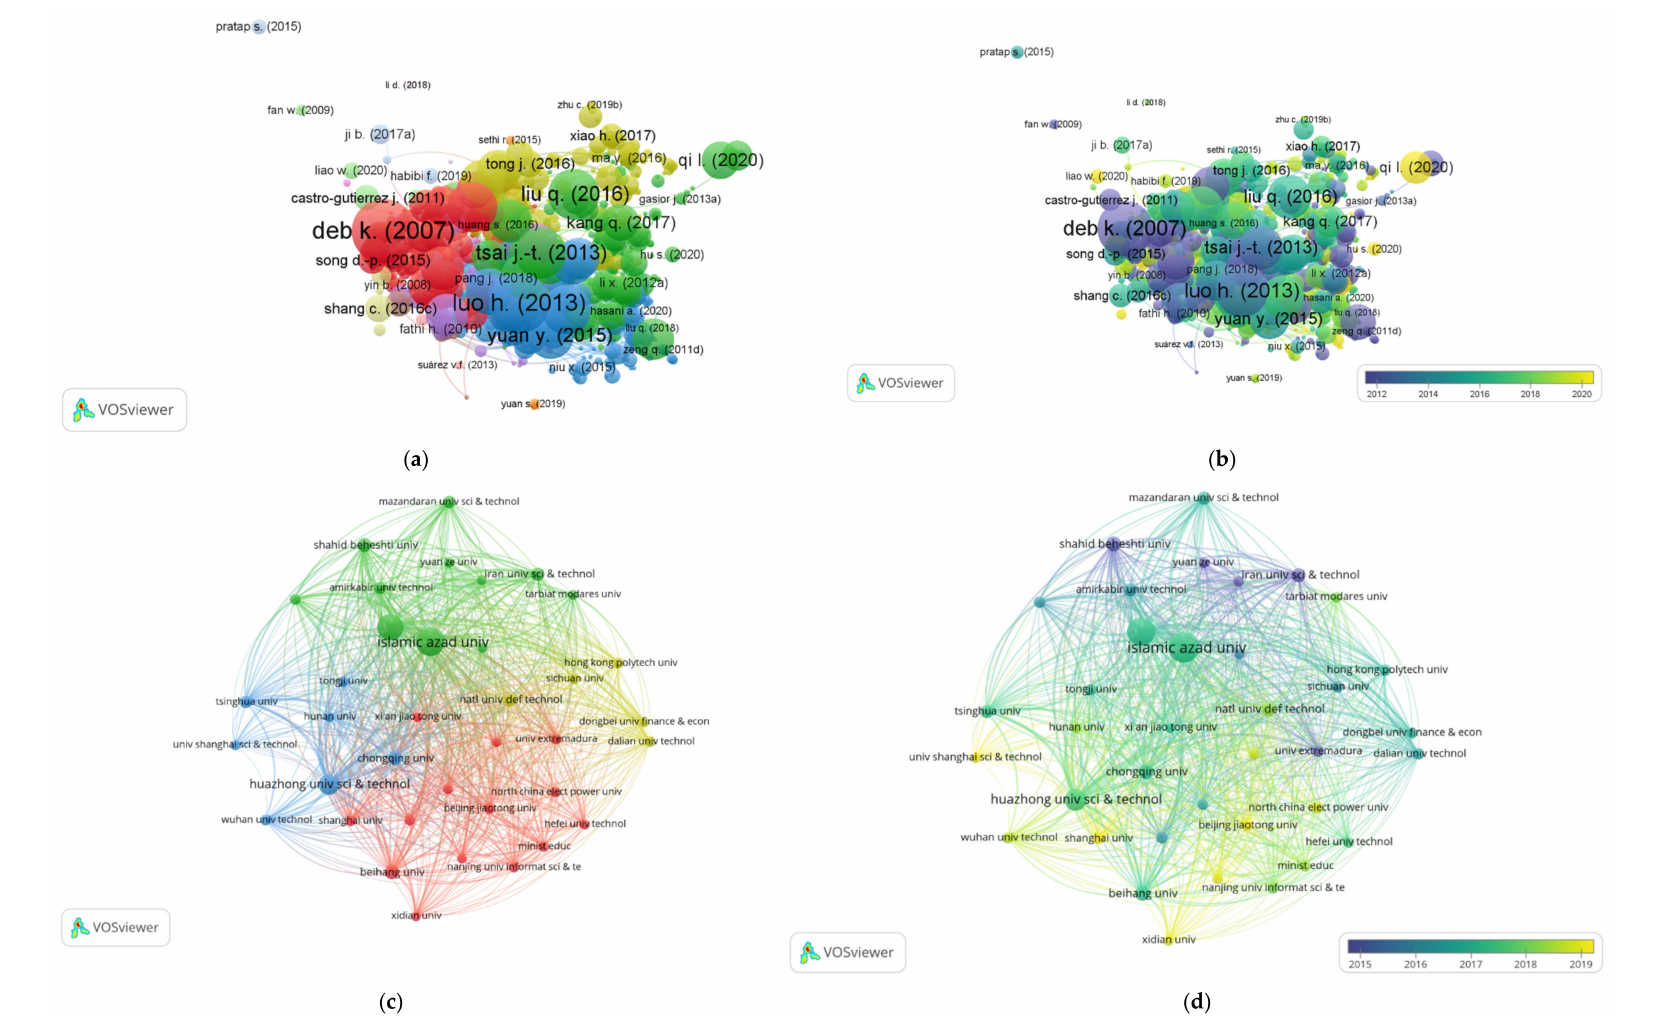
Figure 13. Bibliographic coupling (network and overlay visualization). ( a ) Network visualization bibliographic coupling document ( b ) Overlay visualization bibliographic coupling document ( c ) Network visualization bibliographic coupling organization ( d ) Overlay visualization bibliographic coupling